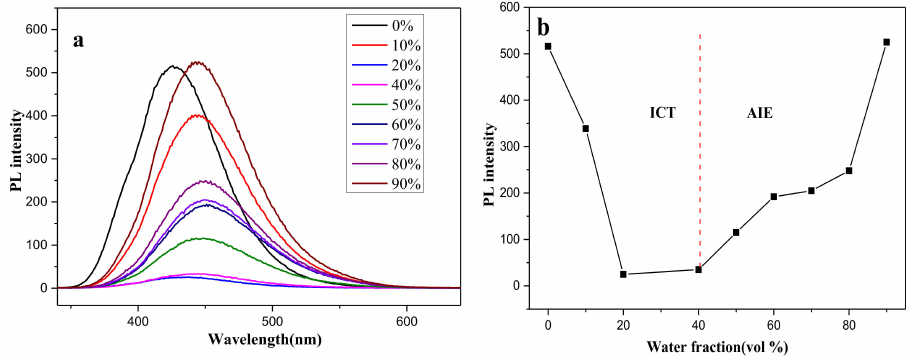
Figure 2. ( a ) PL spectra of 1a in THF/water mixtures with different water fractions (ƒ w ); and ( b ) plot of peak intensity of 1a versus ƒ w in the THF/water mixtures (10 − 5 mol · L − 1 , excitation wavelength: 322 nm).